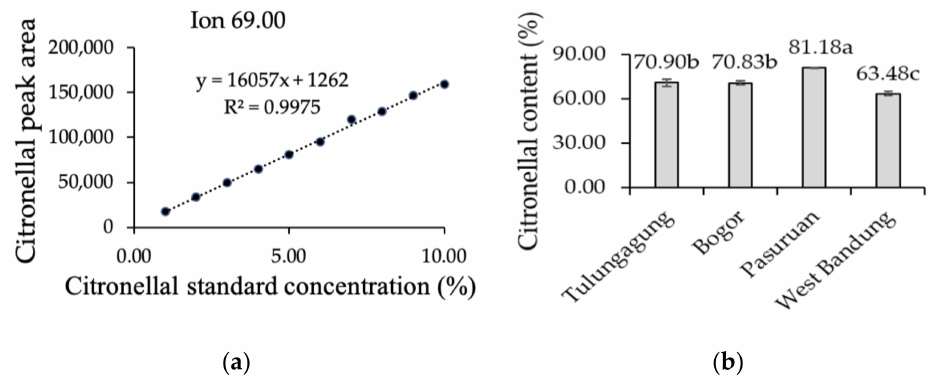
Figure 2. ( a ) Optimization curves of citronellal content in the ion 69; ( b ) Citronellal content in the kaffir lime leaves essential oils from four growing locations. Note: in the bar chart of citronellal content, the different alphabet above the rectangular bar is significantly different based on the Duncan’s multiple range test at α 5%; the error bar represents the standard